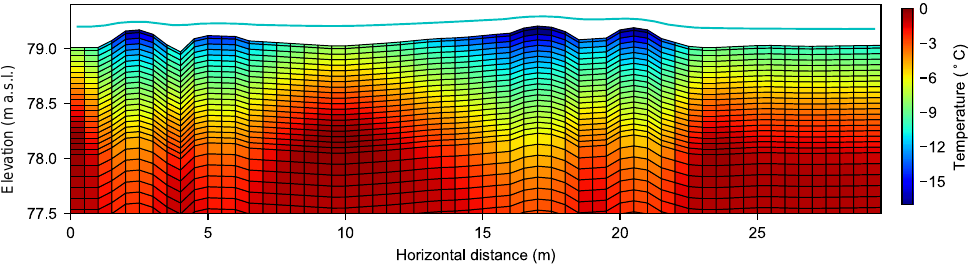
Figure 7. Snapshot of simulated snowpack surface (cyan line) and ground temperature on 24 December 2014 (vertical exaggeration = 4). Only near-surface is shown; spatial domain of simulation extends to 50m below the ground surface. Table 5. Sensitivity analysis: minimum simulated temperature at top of ice wedge ( ◦ C). Trough Rim manipulation (cm) manipulation (cm) − 10 −